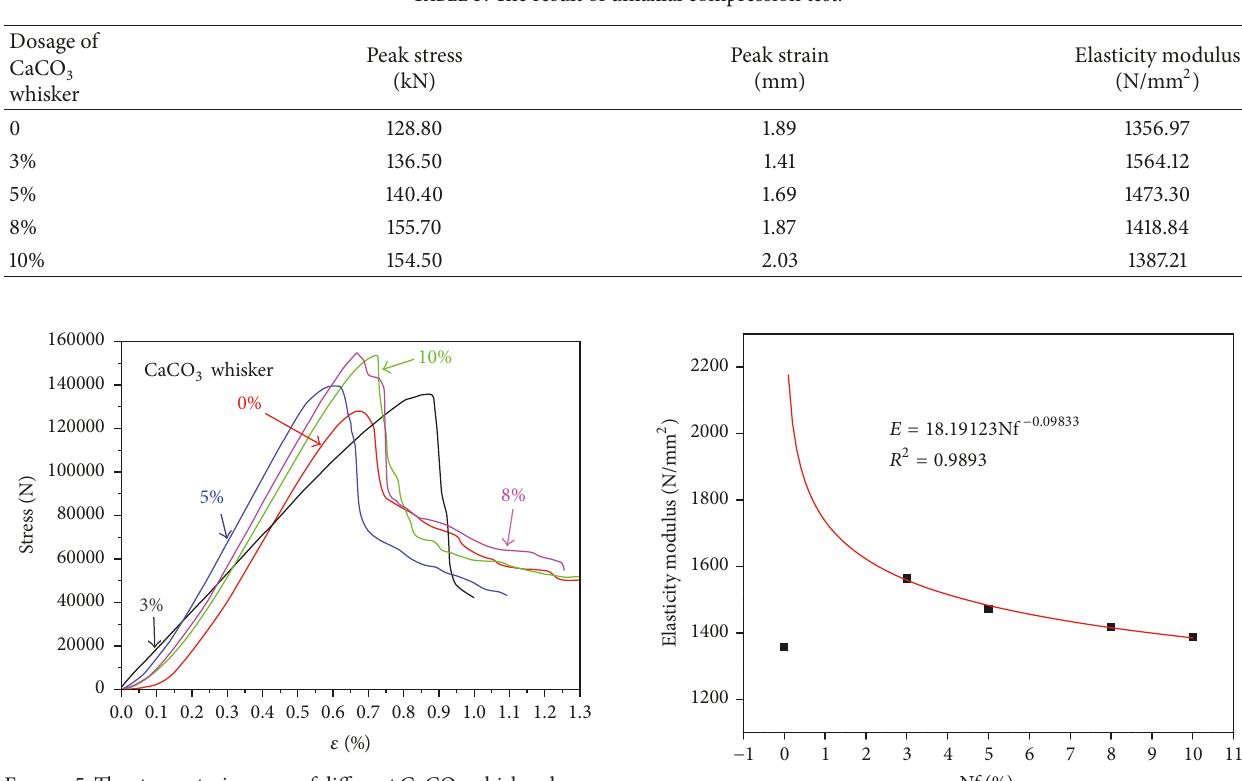
Table 3: The result of uniaxial compression test.